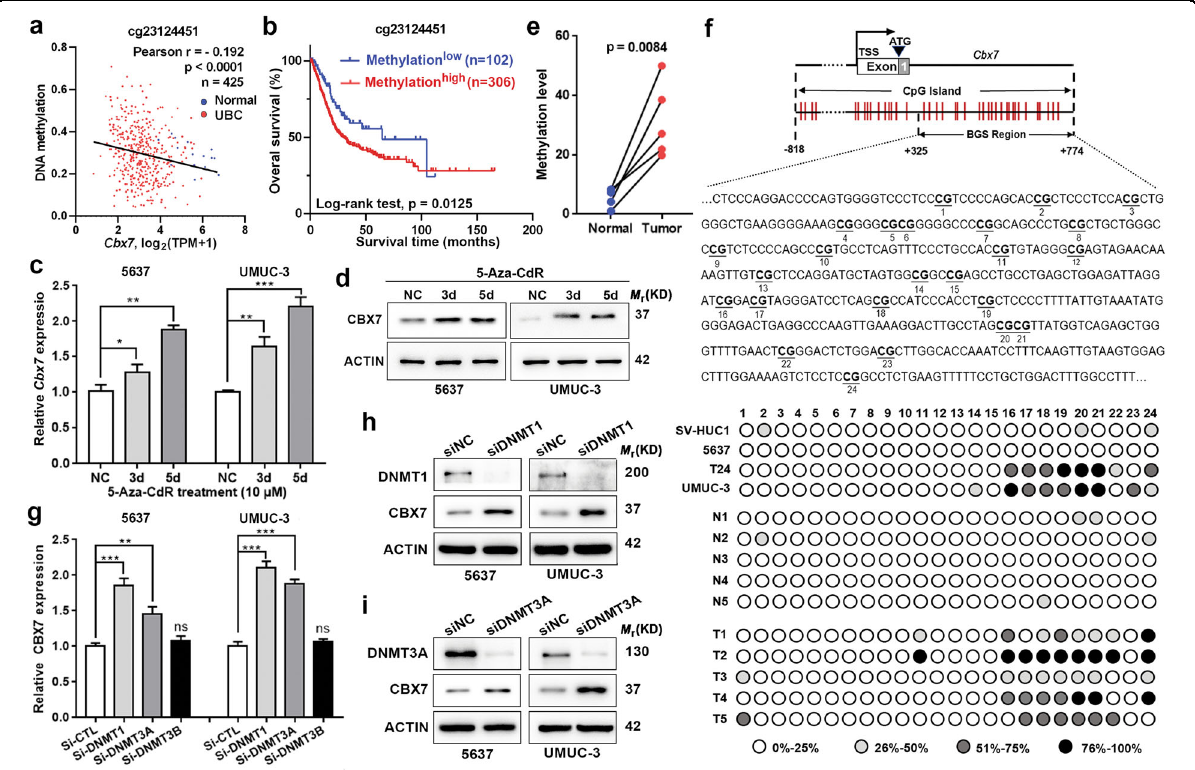
Fig. 4 CBX7 is inactivated by promoter hypermethylation mediated by DNMT1 and DNMT3A in UBC. a Pearson correlation analysis showed a signi fi cant negative correlation between CBX7 methylation level and mRNA expression from TCGA dataset. b Kaplan – Meier survival plot was constructed according to the methylation level. c , d mRNA and protein levels of CBX7 were restored in UBC cells after treatment with 5-Aza-CdR at 10 μ M for the indicated times. e , f Bisul fi te genomic sequencing (BGS) analysis of CBX7 CpG island region. Methylation status of CBX7 was observed in UBC cell lines and paired UBC tissues (T) and their adjacent noncancerous tissues (N). g CBX7 mRNA levels were examined in DNMT1, DNMT3A, or DNMT3B-silenced 5637 and UMUC-3 cells by qRT-PCR. h , i Western blotting results showed that knockdown of DNMT1 and DNMT3A in 5637 and UMUC-3 cells signi fi cantly elevated the level of CBX7. Data are presented as means ± SD from three independent replicates. * p < 0.05, ** p < 0.01, *** p < 0.001, ns nonsigni fi